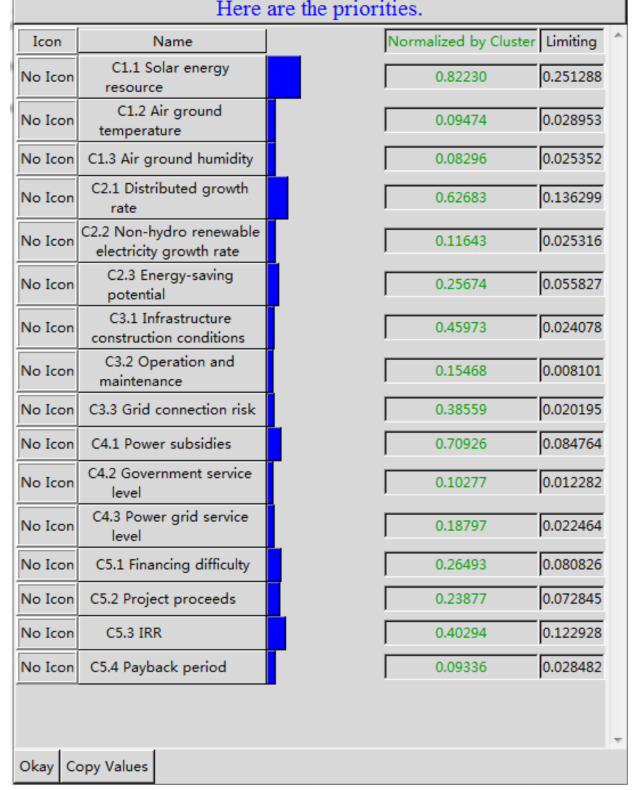
Figure A2. The subjective weight of the indicator is obtained by SuperDecisions.